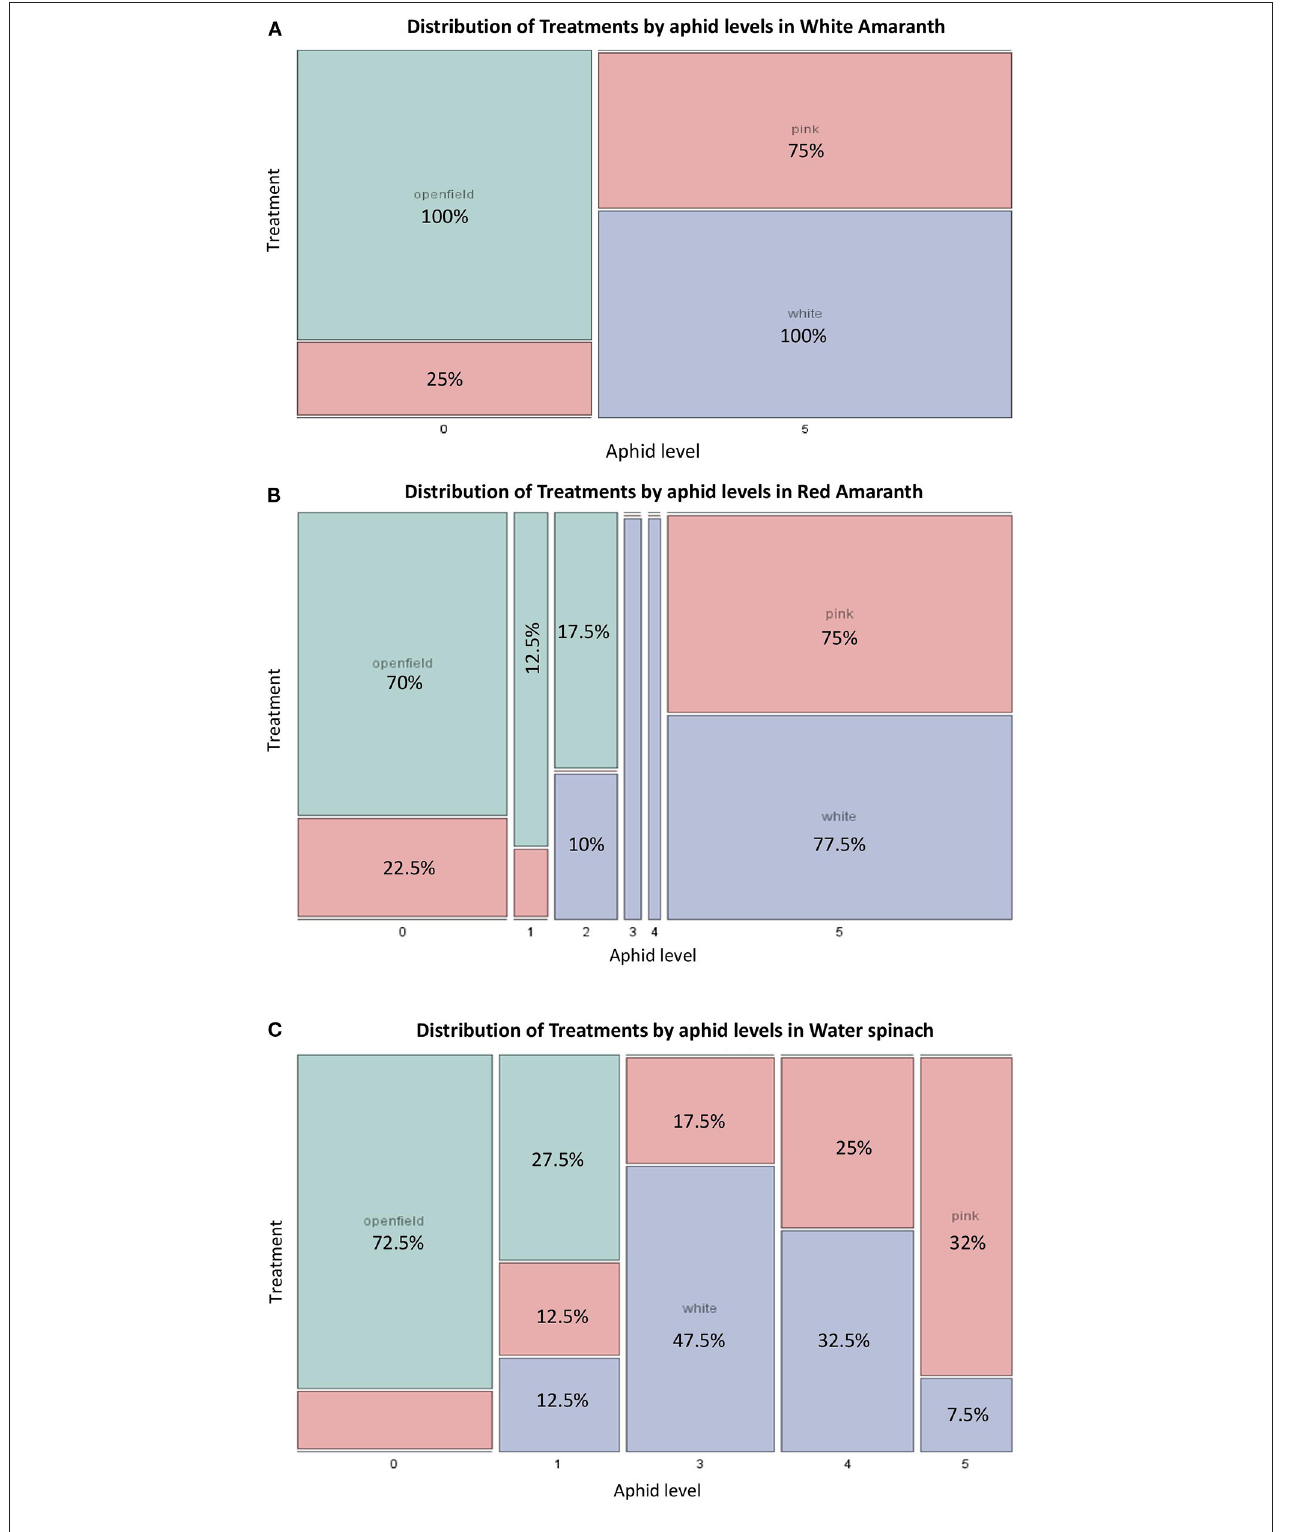
FIGURE 3 | Mean incidence of aphids on leafy vegetables grown under different production conditions. (A) White amaranth, (B) Red amaranth, (C) Water spinach. Means represent average of four replications in each treatment/season.